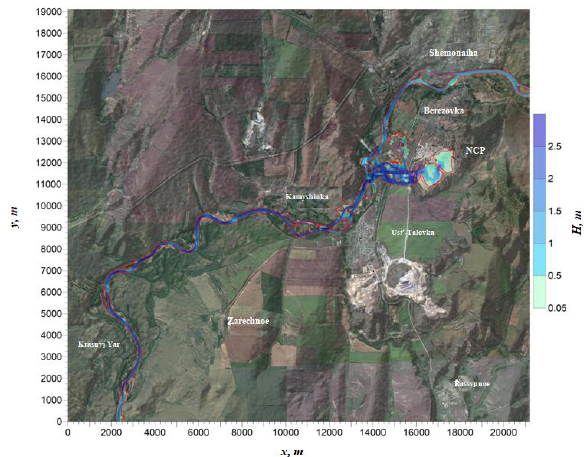
Figure 6. Depth distribution in the flood zone during the development of a hydrodynamic accident (Model 3 including the river) at the tailings storage facility of the concentrator.